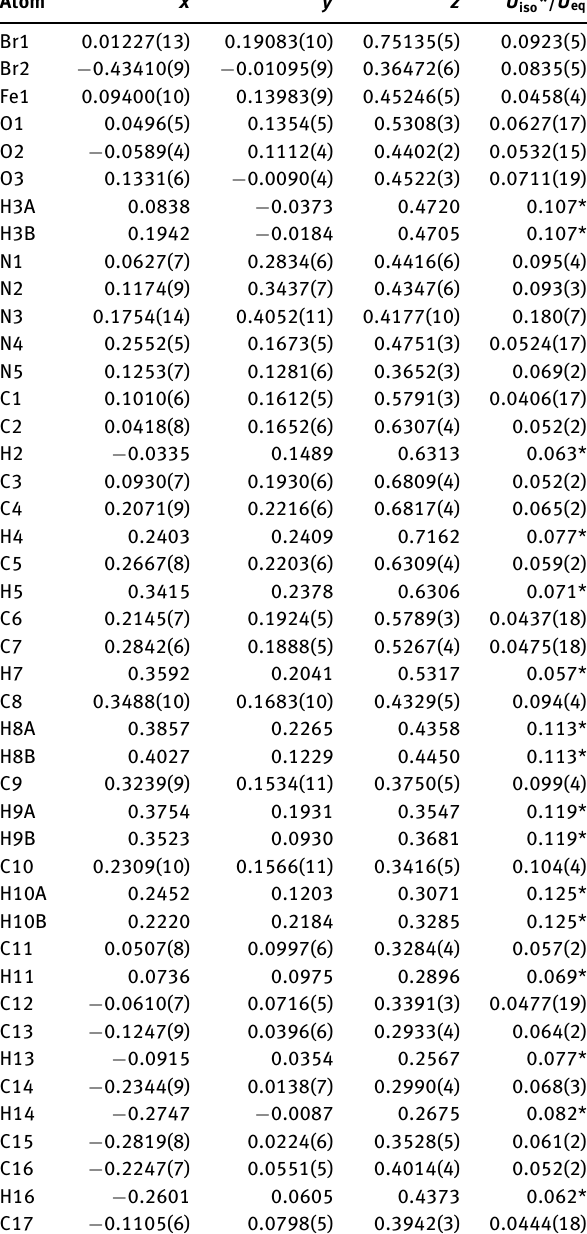
Table 2: Fractional atomic coordinates and isotropic or equivalent isotropic displacement parameters (Å 2